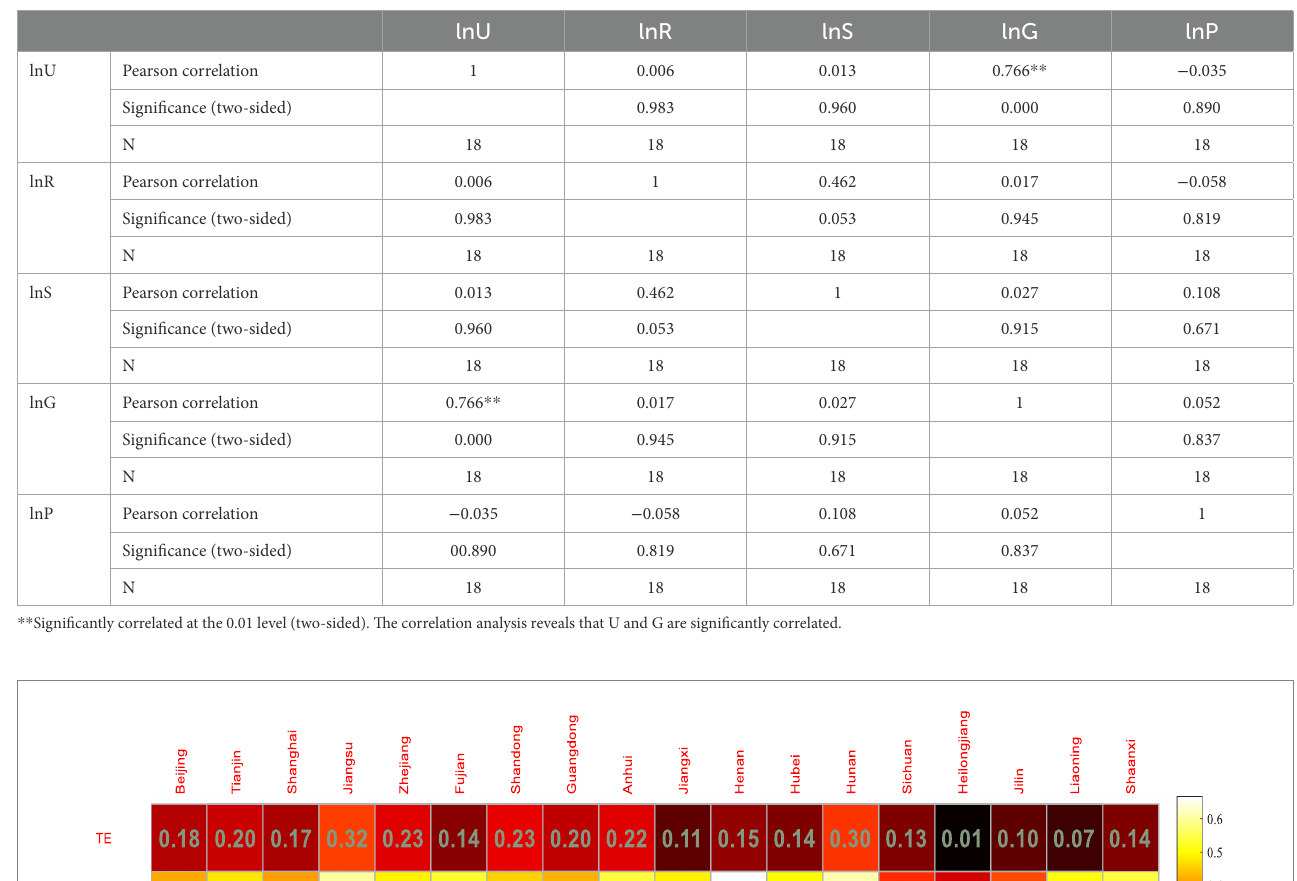
TABLE 2 Correlation analysis.